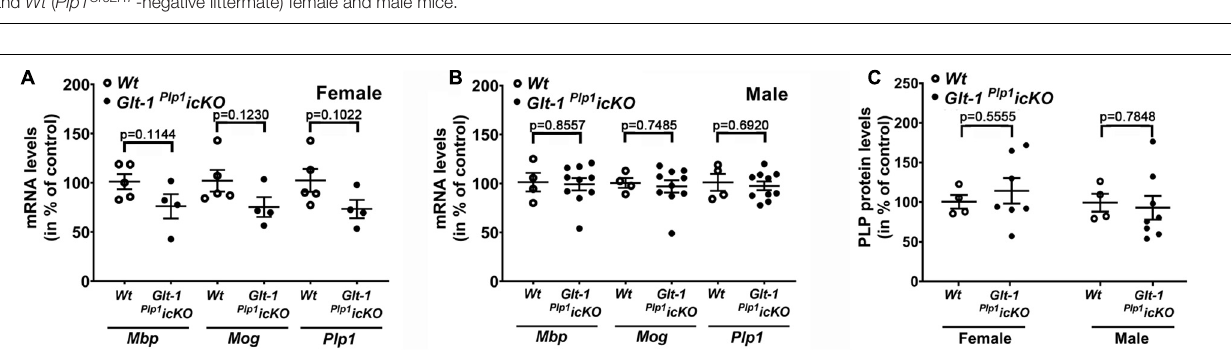
anti-rabbit IgG, Thermo Fisher Scientific Cat# A-11008,